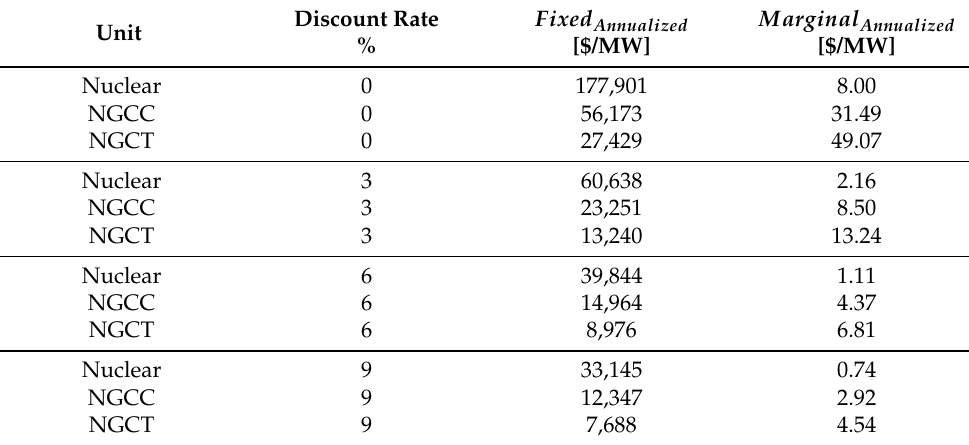
Table 4. The annualized capital and operating costs of power plants (SMR